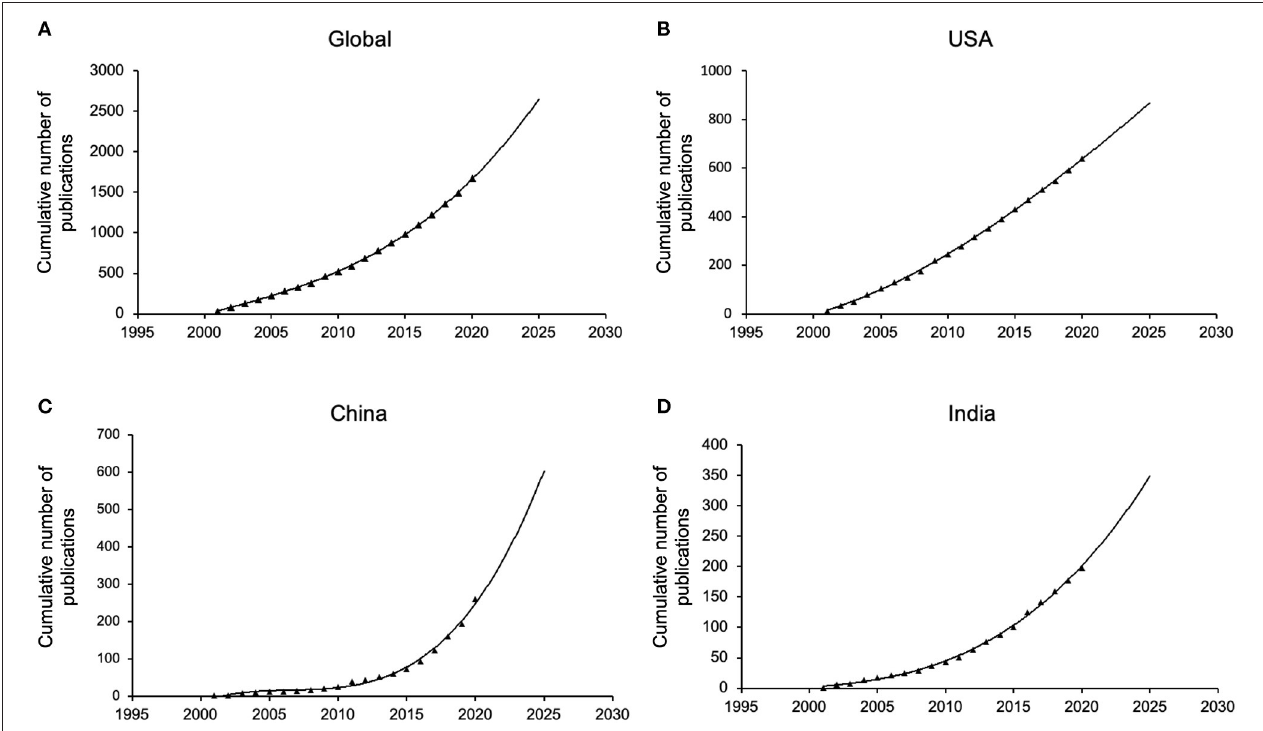
FIGURE 3 | Fitting curves of publication growth trends concerning the retinoblastoma research. (A) Global; (B) the United States; (C) China; (D)